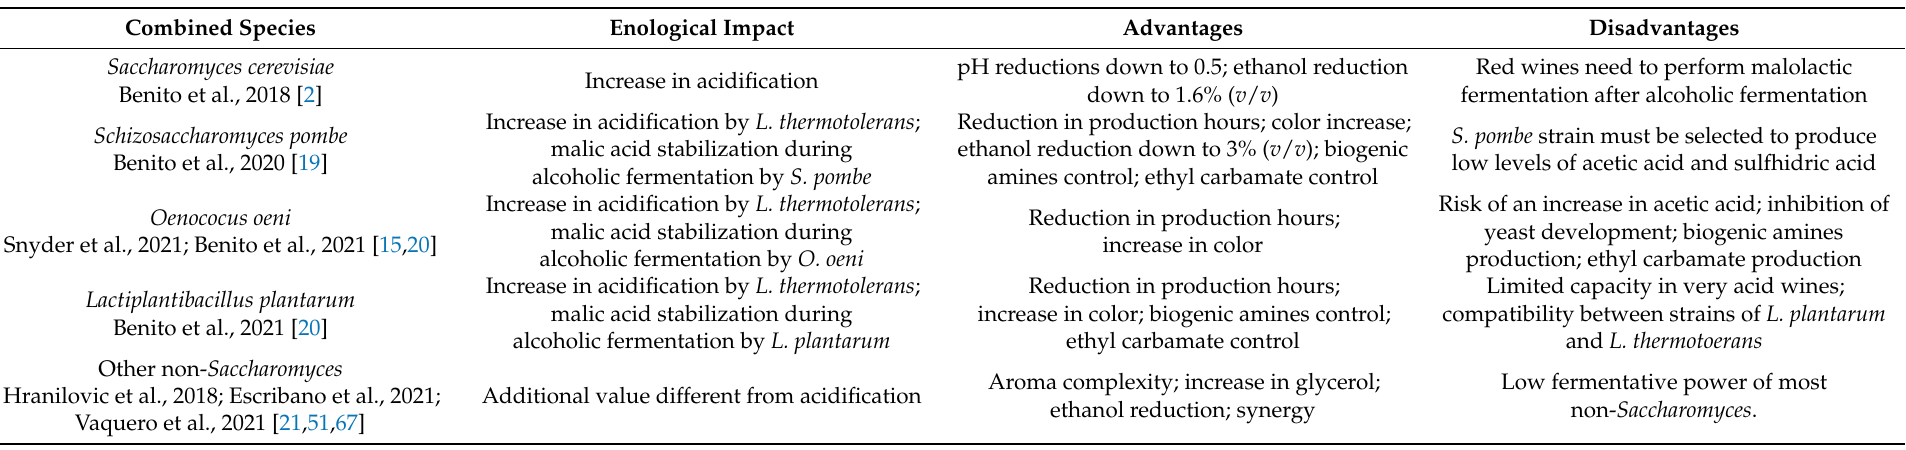
Table 4. Summary of the main L. thermotolerans combinations in winemaking during alcoholic fermentation, explaining their enological impact, advantages, and